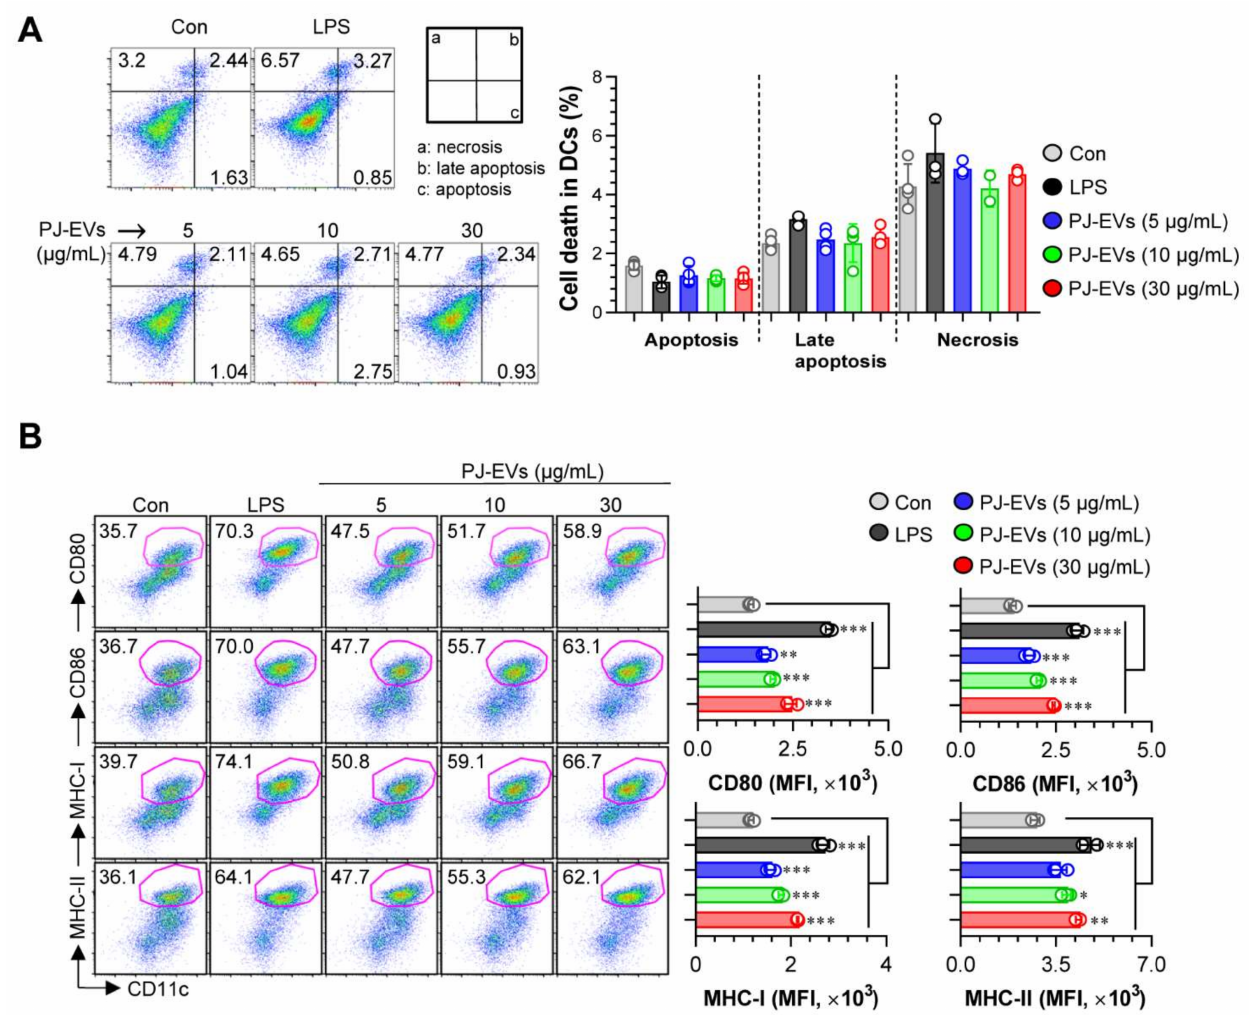
Figure 2. Cytotoxic activity and expression of surface molecules in dendritic cells (DCs) treated with PJ-EVs. ( A ) Cytotoxicity of PJ-EVs in DCs assessed using AnnexinV/propidium iodide (PI) staining (PI + cells: necrosis; AnnexinV + PI + cells, early necrosis; AnnexinV + cells, apoptosis). ( B ) Expression of CD80, CD86, MHC-I, and MHC-II in CD11c + -gated cells measured by FACS. The percentage and mean fluorescence intensity of surface molecules in CD11c + cells are shown in each panel. * p < 0.05, ** p < 0.01, or *** p < 0.001. SD: standard